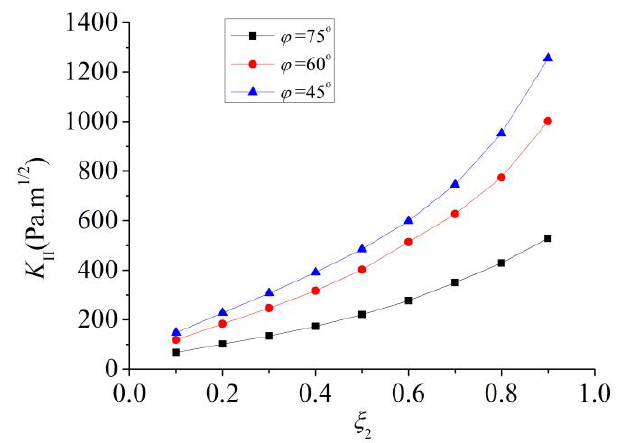
Figure 23. K I − ξ 2 curves for different crack inclination angles. K − curves for different crack inclination angles. 2